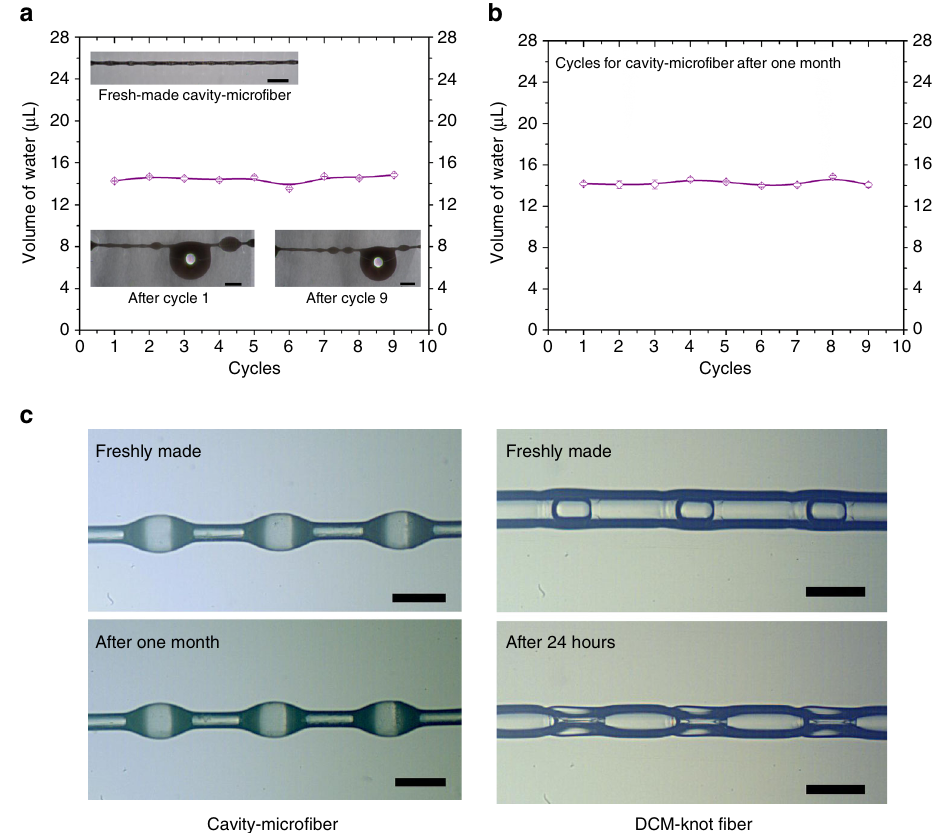
Fig. 4 The durability of cavity-micro fi bers. a A plot of the maximum water volume collected by cavity-micro fi ber against the water-collecting cycles in each water-collecting cycle. Insets showing the cavity knots maintain their shapes after cycles of water collection. b A plot of the maximum water volume collected by cavity-micro fi ber stored for a month against the water-collecting cycles in each water-collecting cycle. c The cavity-micro fi ber maintains its morphology after 1 month, while the knots of the dichloromethane-droplet-templated fi ber (DCM-knot fi ber) deform greatly after 24 h. All error bars in ( a ) and ( b ) indicate the standard deviations over fi ve independent measurements. Scale bars, 1 mm in ( a ) and 400 μ m in ( c minor semi-axis of the spindle knot 11 . By balancing the adhesive